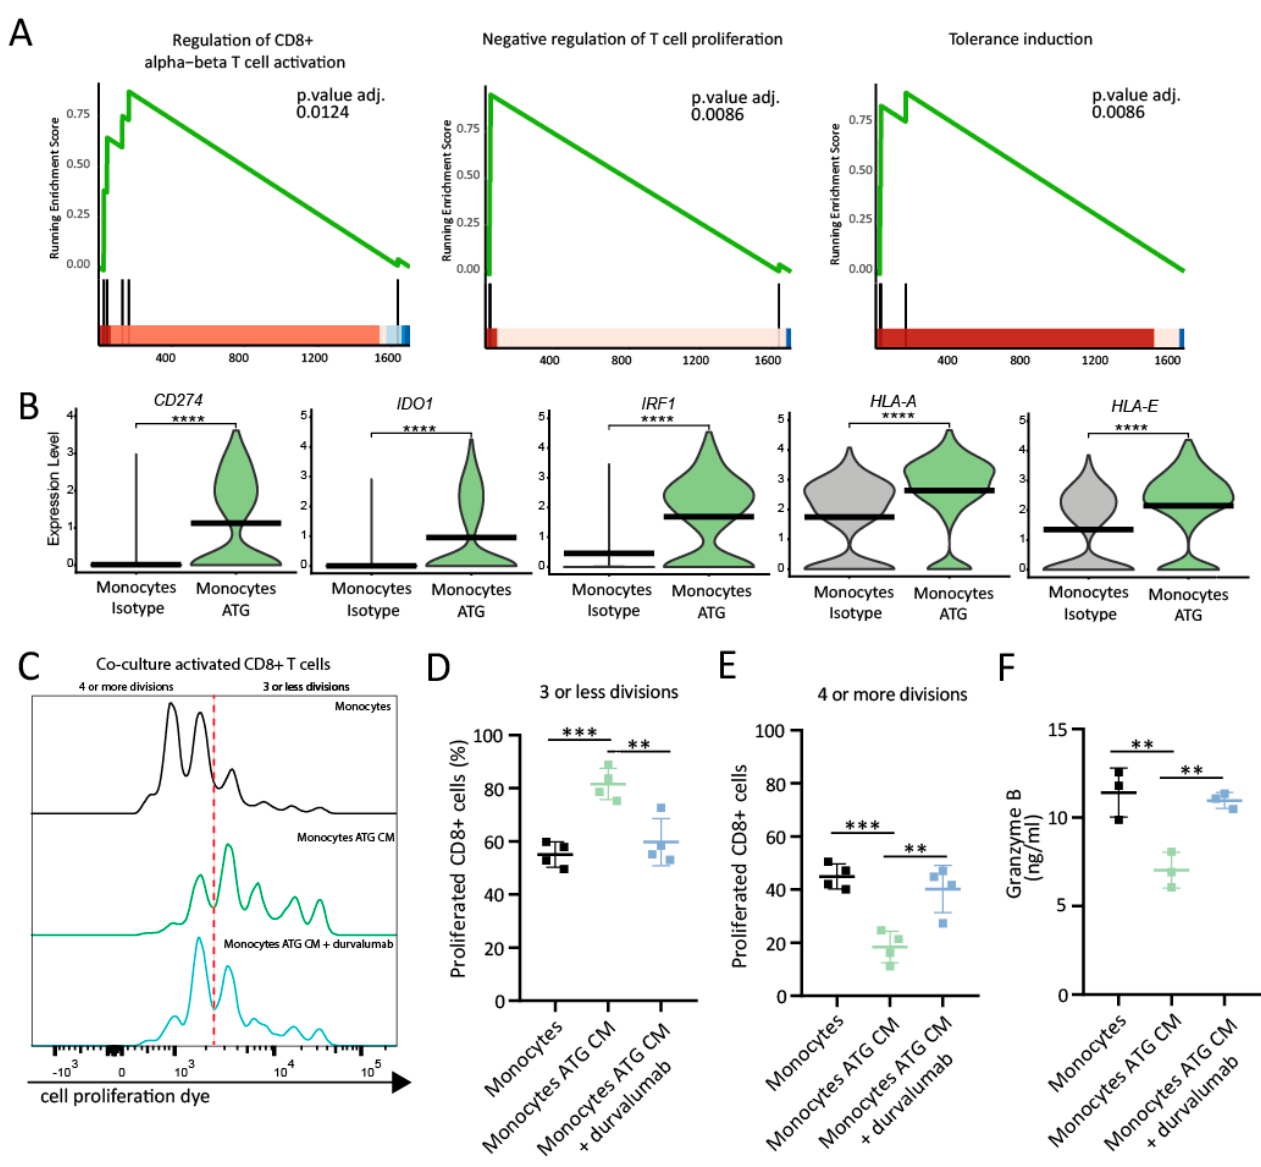
Figure 5. PDL-1 + monocytes reduce proliferation and granzyme B release of activated CD8 + T cells. ( A ) GSEA enrichment plot for the regulation of T cell functions and tolerance induction in monocytes following treatment with ATG. The green lines depict the running enrichment score, and the black vertical lines indicate the genes responsible for the enrichment and position in the ranked list of DEG. ( B ) Violin plots of core enrichment genes CD274 , IDO1 , IRF1 , HLA-A and HLA-E in monocytes treated with the isotype control vs. monocytes treated with ATG. Expression levels are indicated by violin plot height, while width represents the proportion of positive cells. Crossbars mark mean expression. **** indicates p -value < 0.0001. ( C ) Representative histogram of the proliferative capacity of activated CD8 + T cells co-cultured with monocytes (black), PDL-1 + monocytes (green) and durvalumab-pretreated PDL1 + monocytes (blue). Non-proliferating (furthest right) and proliferating cell populations are reflected by the intensity of cell proliferation dye staining. The dashed red line separates cells with 3 or less divisions from cells with 4 or more divisions. ( D ) Bar graph depicting the mean percentages of CD8 + T cells with 3 or fewer proliferations and ( E ) 4 or more proliferations on day 5. N = 4 donors per group. *** p -value = 0.0009; ** p -value = 0.0034. One-way ANOVA with Dunnett’s multiple comparison was used to determine statistically significant differences. ( F ) Concentration of granzyme B in a conditioned medium of CD8 + T cells co-cultured with monocytes assessed by ELISA. ** p -value <